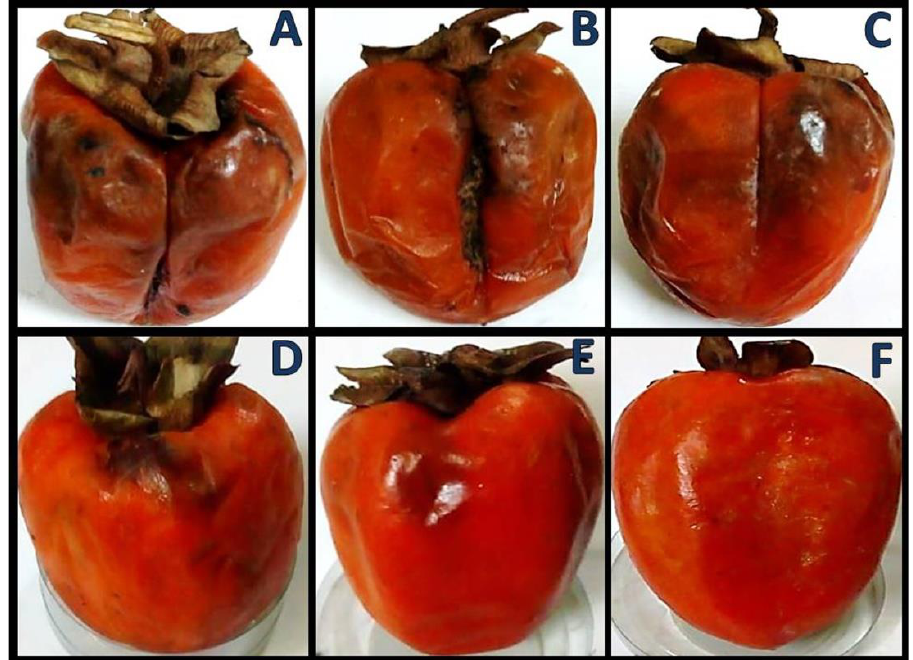
Figure 3. Examples of infected persimmon fruits after coating. ( A ): uncoated; ( B ): water-dipped; ( C ): water-dipped after 7 days; ( D ): coated with 1.0% nanochitosan; ( E ): coated with 0.5% nanochitosan/rosmarinic acid/Se nanocomposite; ( F ): coated with 1.0% nanochitosan/rosmarinic acid/Se nanocomposite, after 14 days of storage for treatments A, B, D, E and F.